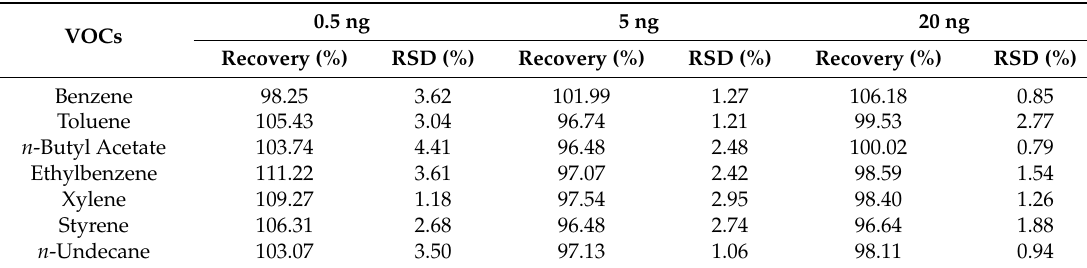
Table 5. The recovery for